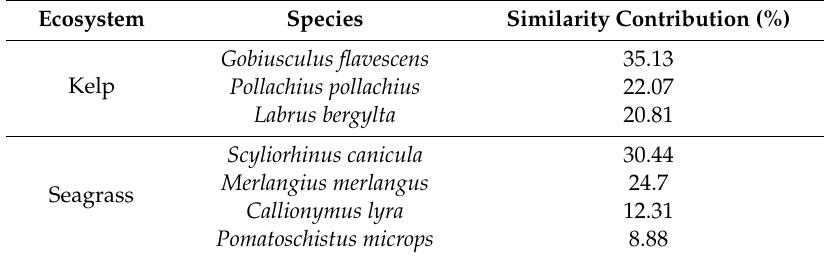
Table 2. The contribution (%) of the most prevalent four species to kelp and seagrass habitats, from BRUVS deployments across the UK west coast between April and September 2017, in a two-way analysis of similarities (SIMPER) across season and site.